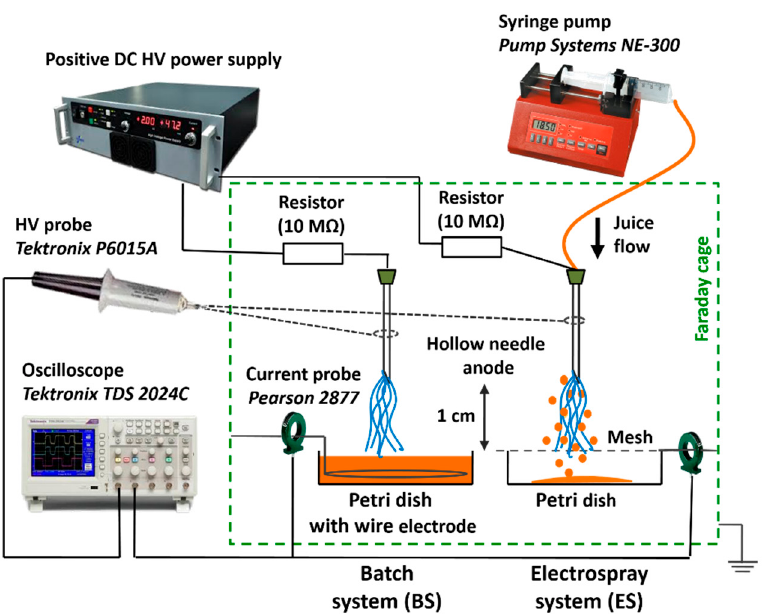
Figure 1. Experimental set-up of air transient spark discharge in batch (BS) and electrospray (ES) systems for juice treatment.